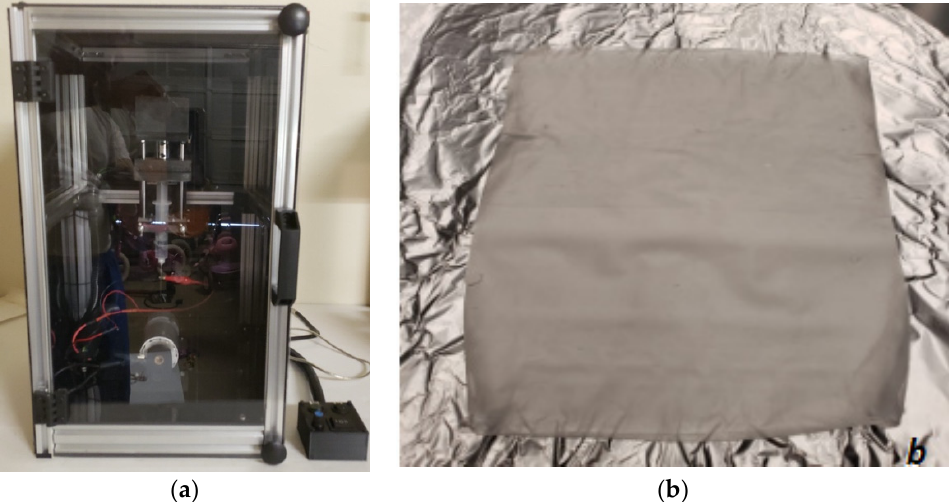
Figure 6. ( a ) Fiber collection on a drum using an electrospinning unit and ( b ) a produced PCL cloth after 10 min of electrospinning from the drum. after 10 min of electrospinning from the